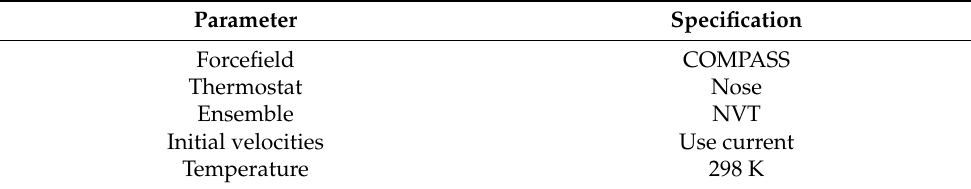
Table 3. Specifications of molecular dynamics simulation.